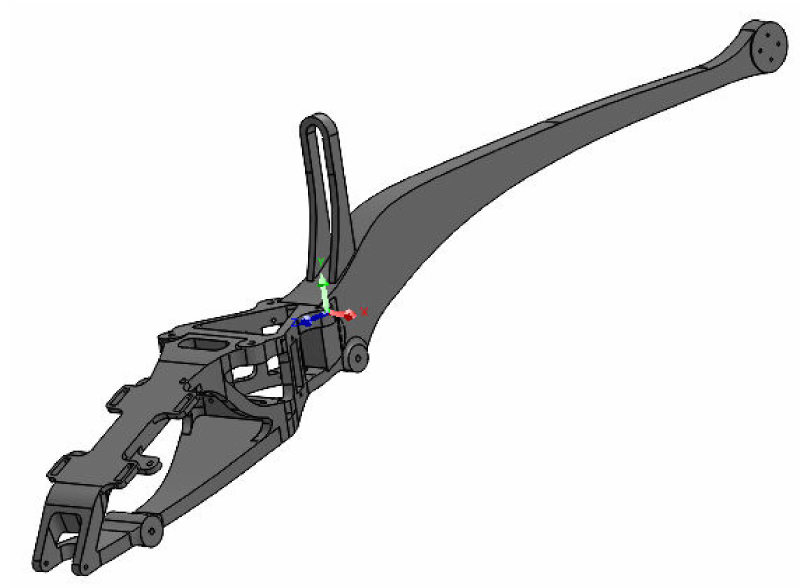
Figure 14. Simplified virtual frame model used in topology analysis of geometry (weight 209.1